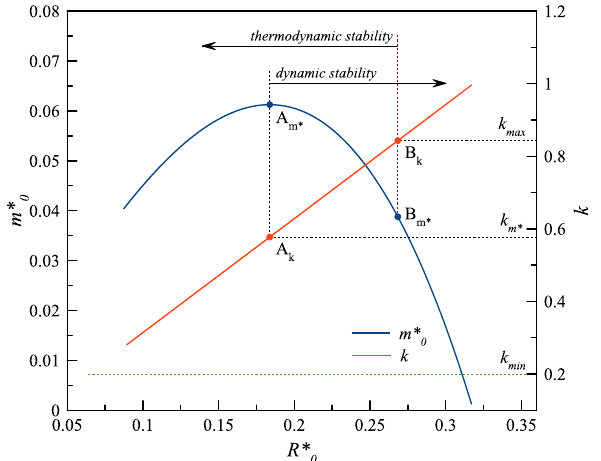
Fig. 8 Dynamic and thermodynamic stability for EOS II with n = 2 Fig. 7 Dynamic and thermodynamic stability regions for EOS II with in the ( a , k ) plane. The curve k max ( a ) follow from Eq. (53). The points n = 2 and a = 0 . 06. The states with k < k min = 1 / 5 (which corre- A k and B k are those in Fig. 7 sponds to a > a max = 12 / 19) violate the DEC. The allowed values of k for thermodynamic stability satisfy k min < k < k max , where k max = 0 . 843130 follows from Eq. (53). The allowed values of k for √ dynamical stability satisfy k m ∗ < k , where k m ∗ = 1 / 3 corresponds = m ∗ ( R ∗ ) to the maximum of the curve m ∗ 0 0 0